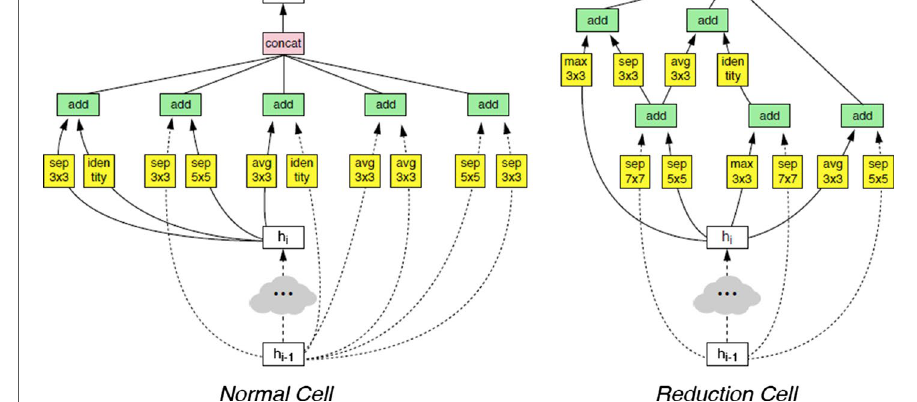
Fig. 8 Architecture of NASNet-A